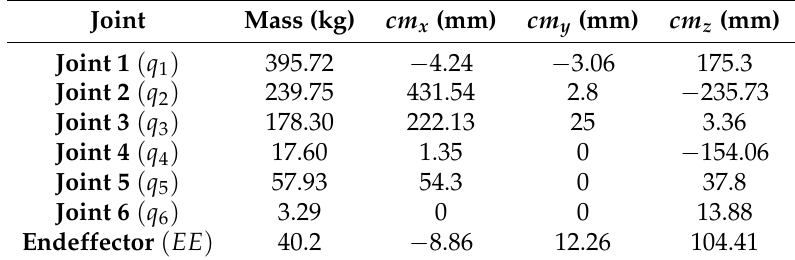
Table A1. Mass and center of mass for the end-effector and each joint for a KUKA KR270 estimated based on its CAD model and its total